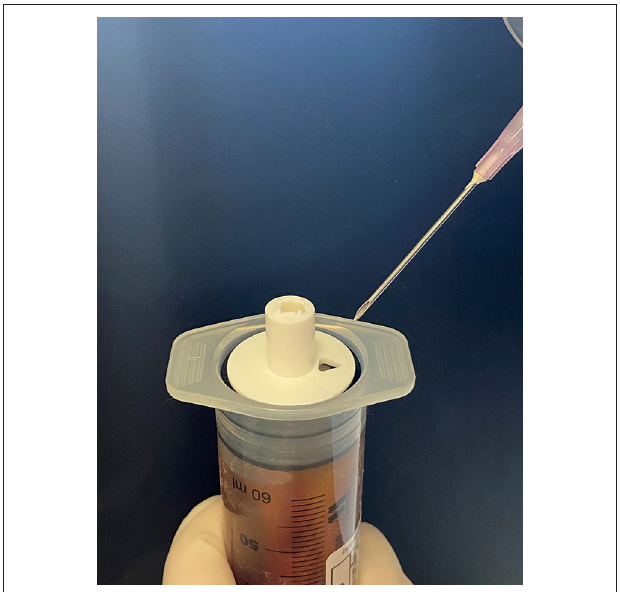
FIGURE 1 | Triangular extraction port of the commercial autologous conditioned serum